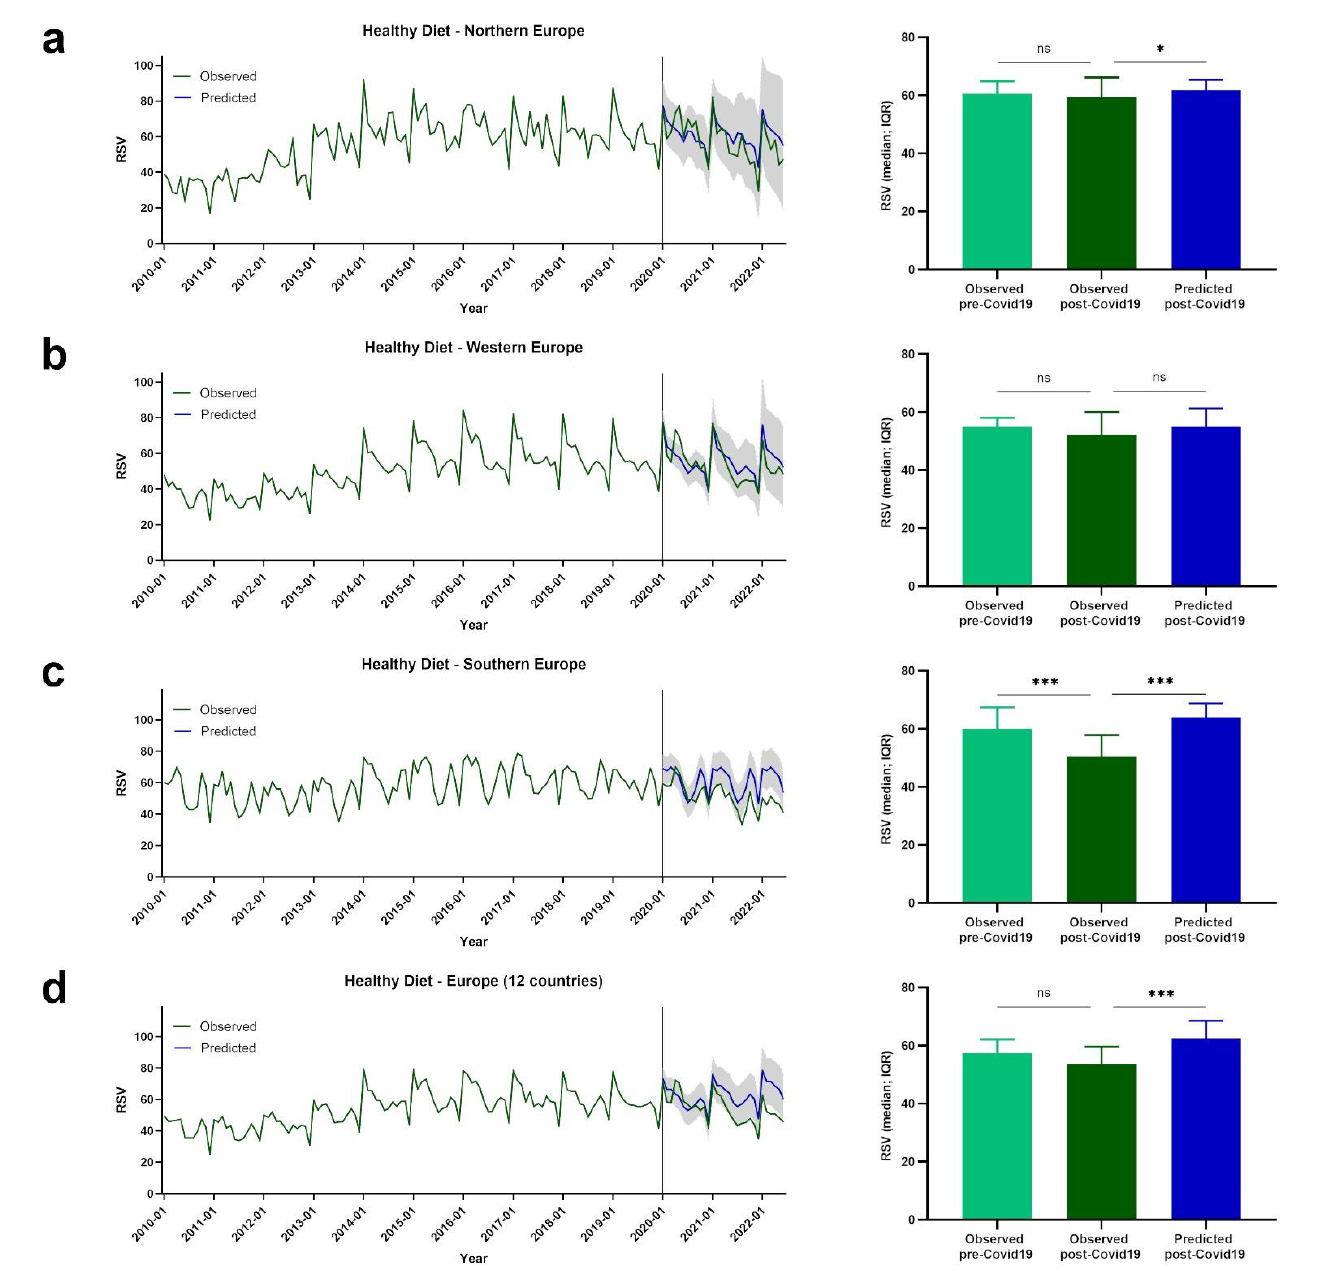
Figure 3. The RSV evolution for Healthy Diet topic. ( a ) Evolution of RSVs for Healthy Diet topic in northern Europe from January 2010 to June 2022 (green line), predicted evolution of RSVs for Healthy diet topic between January 2020 and June 2022 (blue line); gray shadow represents 95% confidence interval. ( b ) Evolution of RSVs for Healthy Diet topic in western Europe from January 2010 to June 2022 (green line), predicted evolution of RSVs for Healthy Diet topic between January 2020 and June 2022 (blue line); gray shadow represents 95% confidence interval. ( c ) Evolution of RSVs for Healthy Diet topic in southern Europe from January 2010 to June 2022 (green line), predicted evolution of RSVs for Healthy Diet topic between January 2020 and June 2022 (blue line); gray shadow represents 95% confidence interval. ( d ) Evolution of RSVs for Healthy Diet topic in Europe from January 2010 to June 2022 (green line), predicted evolution of RSVs for Healthy Diet topic between January 2020 and June 2022 (blue line); gray shadow represents 95% confidence interval. For ( a – d ) bars represent the comparison between median RSVs pre-COVID-19 and post-COVID-19, and between post-COVID-19 and predicted post-COVID-19 data. * p < 0.05; *** p < 0.001; ns — not significant.